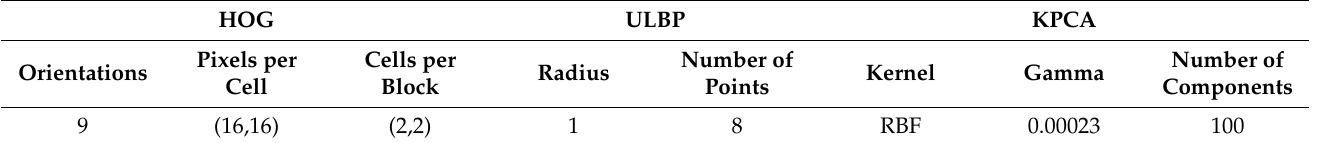
Table 1. HOG, ULBP, and KPCA hyperparameters.